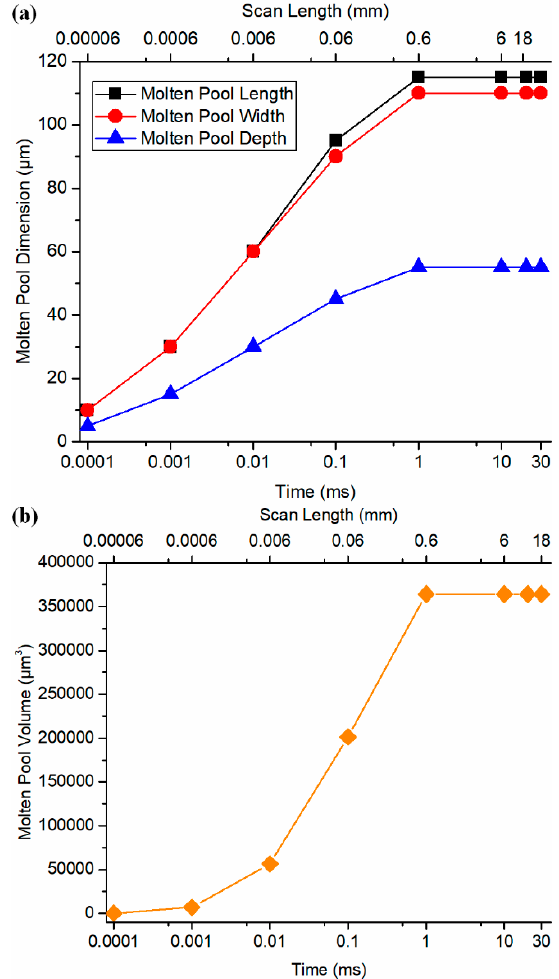
Figure 7. Molten pool growth and stabilization during the single-track scan of SLM of AlSi10Mg with P = 180W, V = 600 mm/s. ( a ) Molten pool length, width, and depth, and ( b ) molten pool volume.